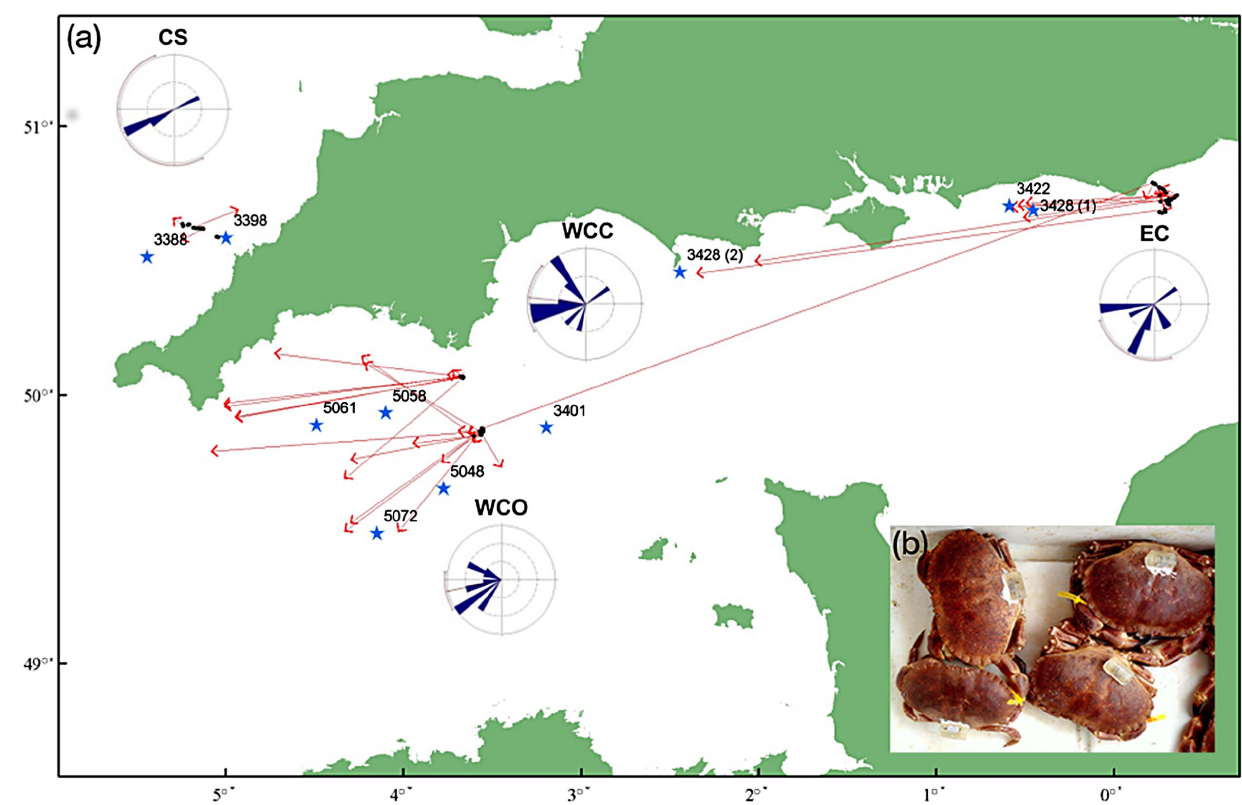
Figure 1. Migration routes and brooding locations of edible crabs Cancerpagurus tagged with electronic data storage tags (DSTs). (a) Release and recapture locations, estimated brooding locations (see text), and distance and direction of movement by edible crabs tagged with electronic data storage tags and released in the English Channel and Celtic Sea from August 2008 to June 2009. Rose diagrams illustrate the mean axes (and 95% confidence limits) of migration. Key: Black dots, release locations; Red lines, direction of travel; red arrowheads, recapture locations; Stars, brooding locations of crabs (tag number) estimated using the tidal location method; EC, Eastern Channel; WCC, Western Channel Coastal; WCO, Western Channel Offshore; CS, Celtic Sea. (b) DST-tagged crabs prior to release.